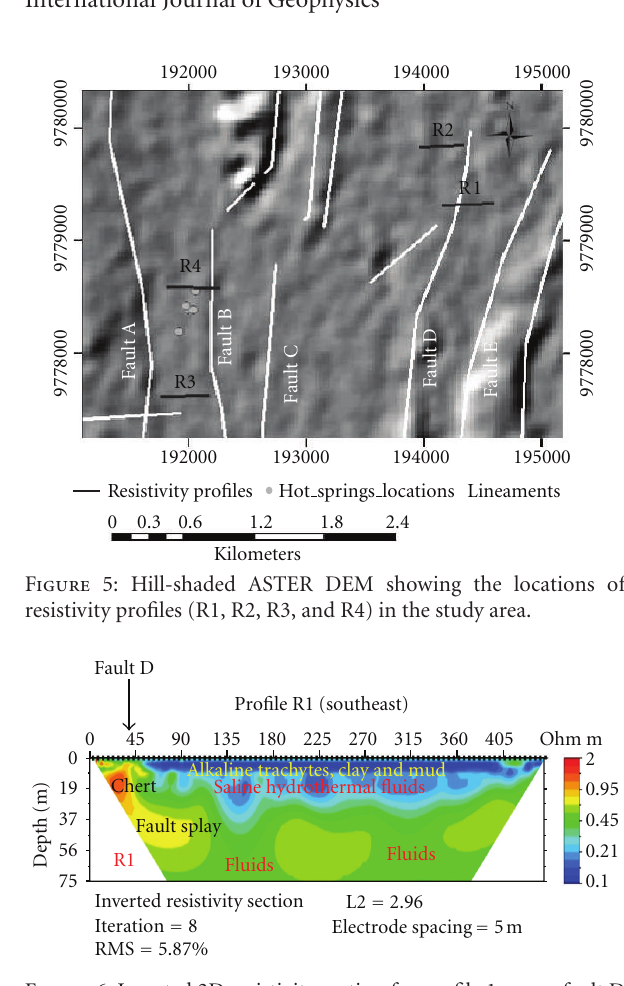
Figure 6: Inverted 2D resistivity section for profile 1 across fault D and towards fault E in the southeast of Lake Magadi.